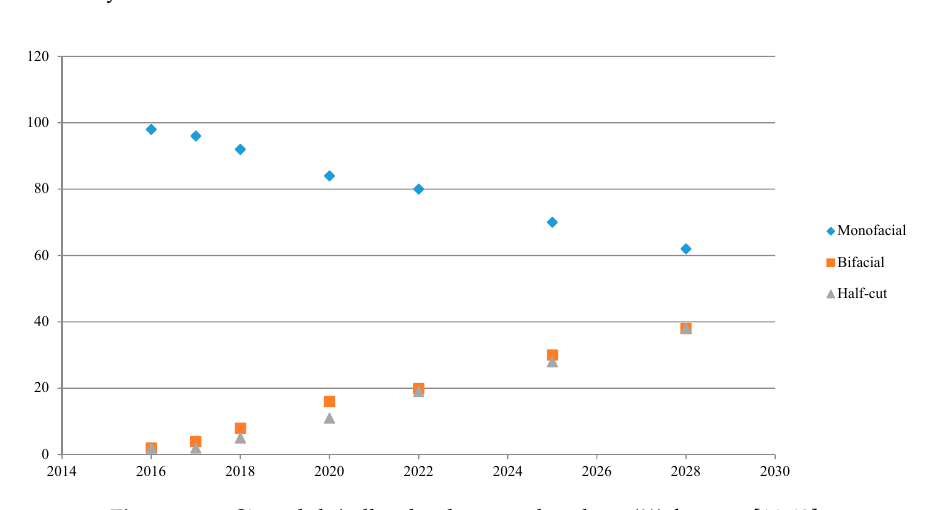
Figure 17. c-Si module/cell technology market share (%) forecast [11,42].